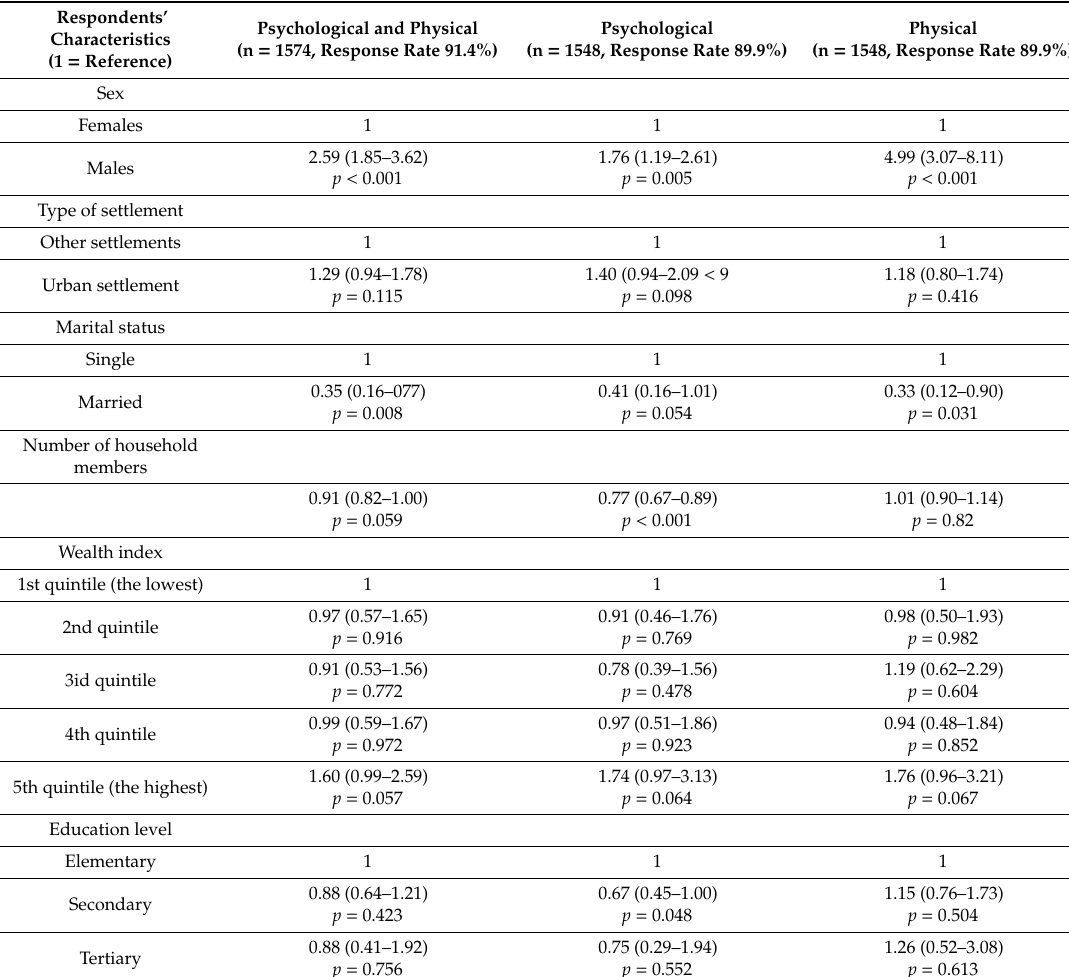
Table 4. Determinants and predictors for violence perpetration (Odds Ratios and 95% Confidence Interval), youth (15–24 years) in Serbia,